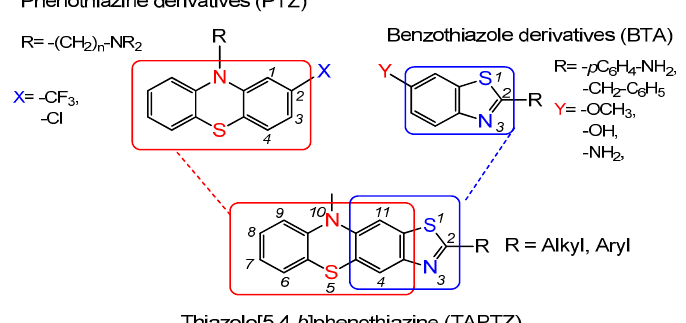
Figure 1. Generic chemical structure and significant substitution pattern for antiproliferative agents derived from PTZ and BTA and their structural complementarities with the target polyheterocyclic TAPTZ structure.